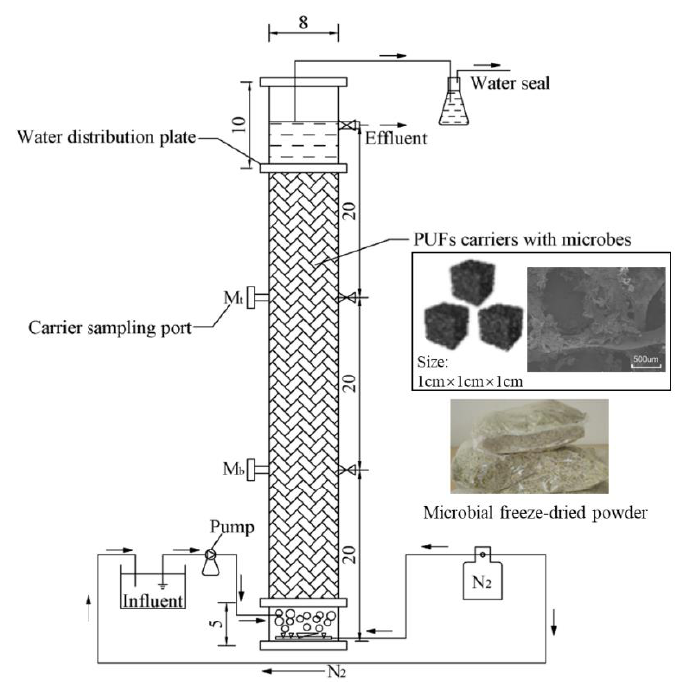
Figure 1. Lab-scale immobilized biofilter.